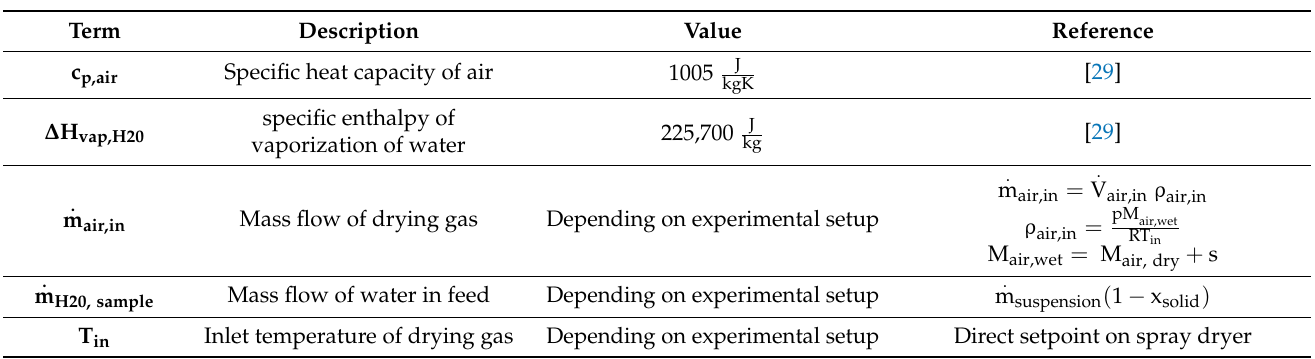
Table 3. Parameters for calculating the outlet